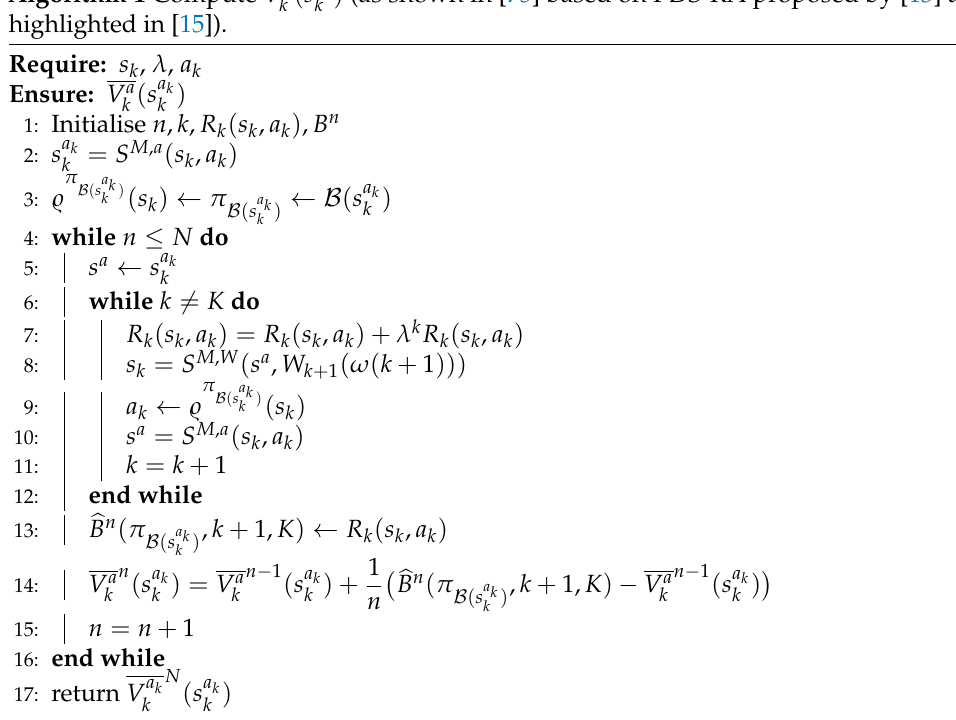
( s a k ) (as shown in [75] based on PDS-RA proposed by [13] and k k